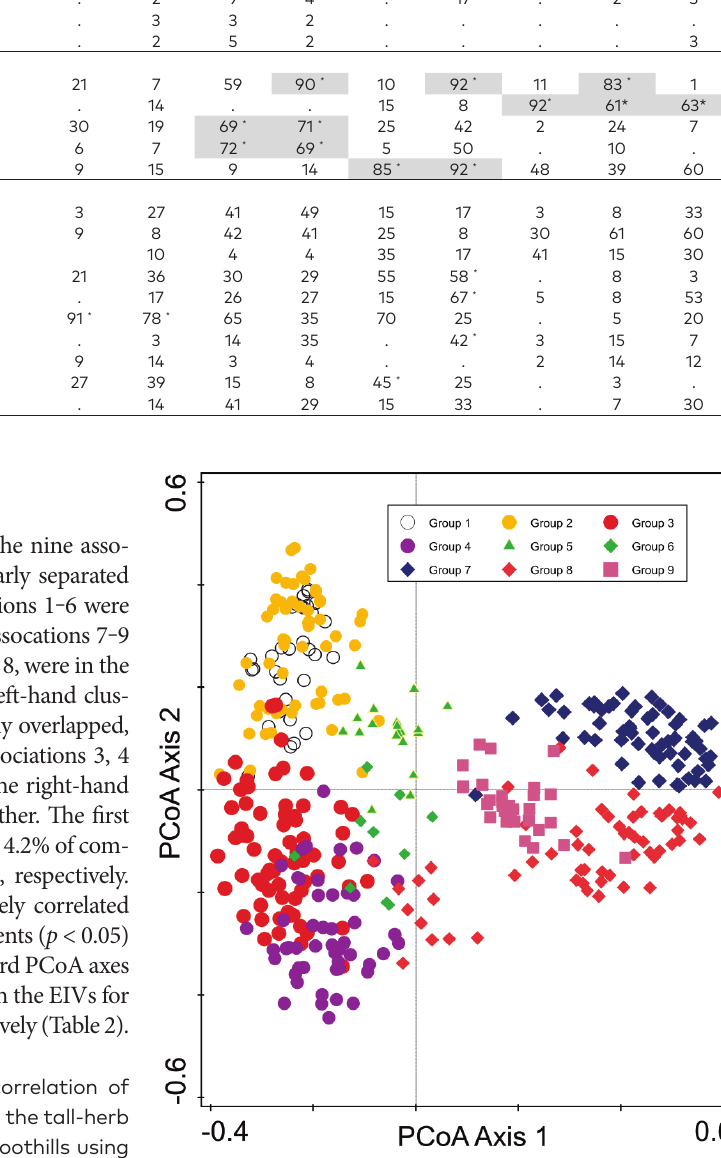
Figure 6. PCoA diagram for the 399 vegetation plots of tall-herb communities in the Sudetes Mts. and their foot- hills (SW Poland). The numbers of clusters are identical with Figure 2. Clusters 1 and 2 refer to submontane com- munities on nutrient-rich, Quaternary deposits; cluster 3 and 4 represent phytocoenoses in shaded sites, located within forest stands in the lower alpine zone; clusters 5 to 9 represent light-demanding and slightly acidophilic phytocoenoses developing from the subalpine to lower alpine zone. Symbols are grouped in alliances: circles: